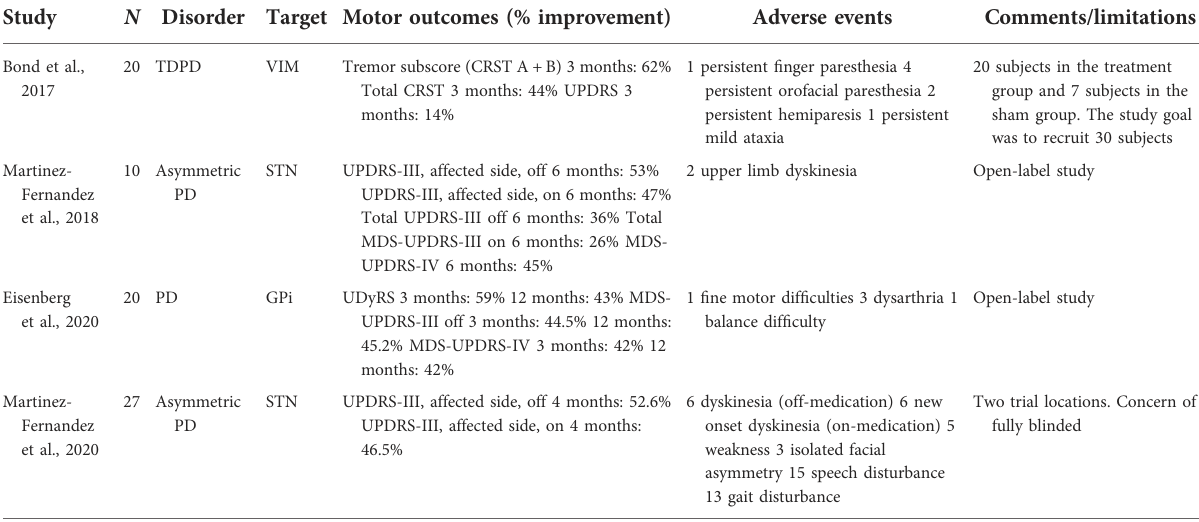
TABLE 2 Key studies evaluating ef fi cacy and safety of MRgFUS. Study N Disorder Target Motor outcomes (%